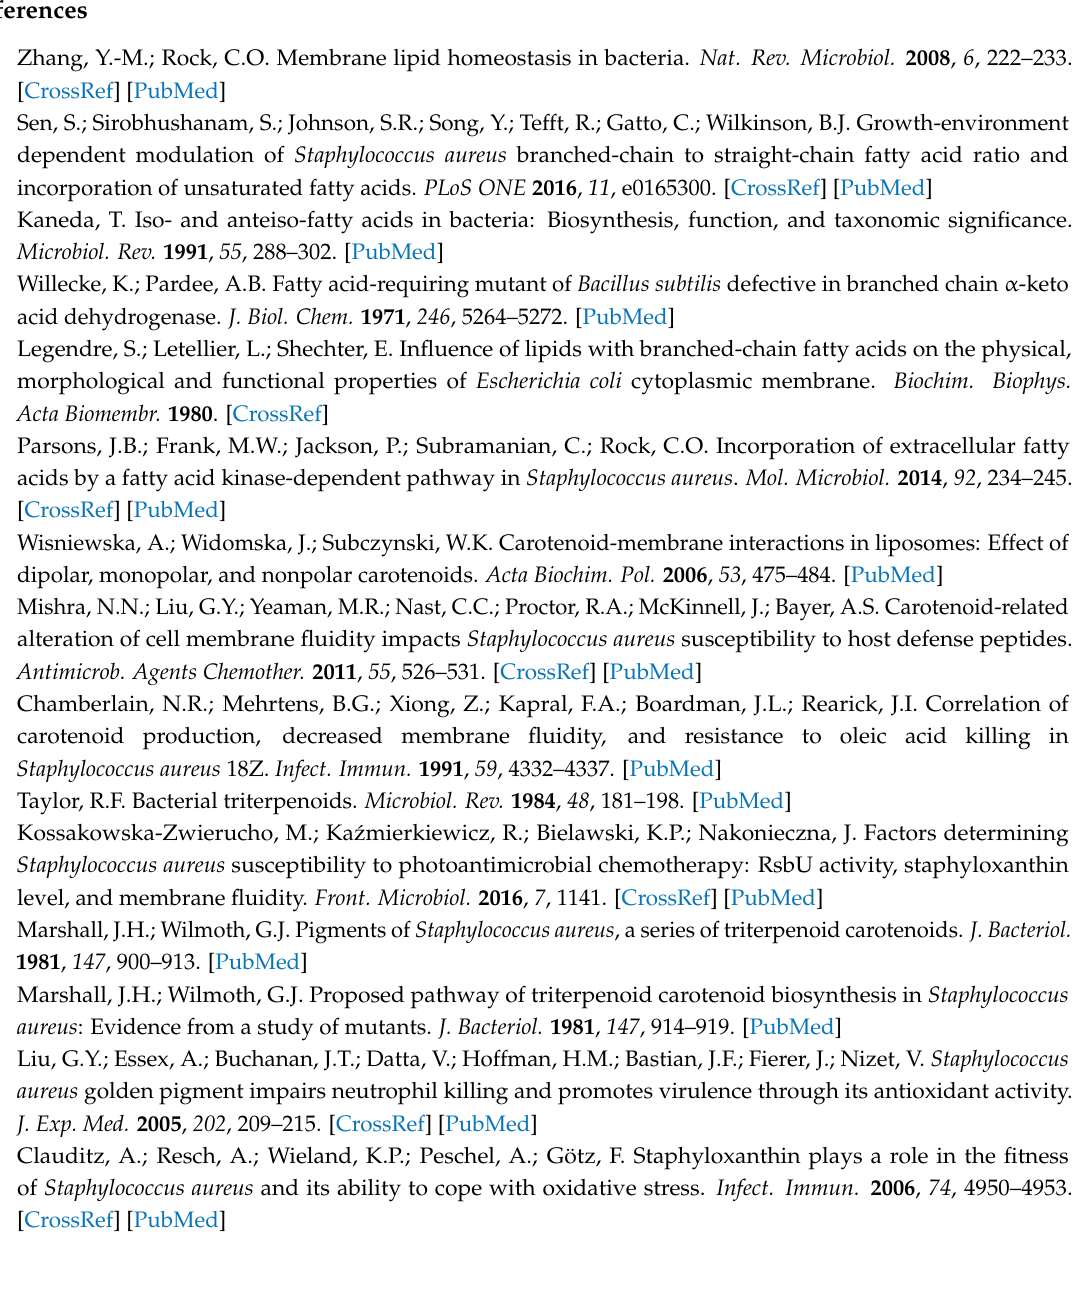
Supplementary Materials: The following are available online, Table S1: Primer sequences used in qRT-PCR assays. Table S2: Fatty acid profiles of S. aureus grown in various